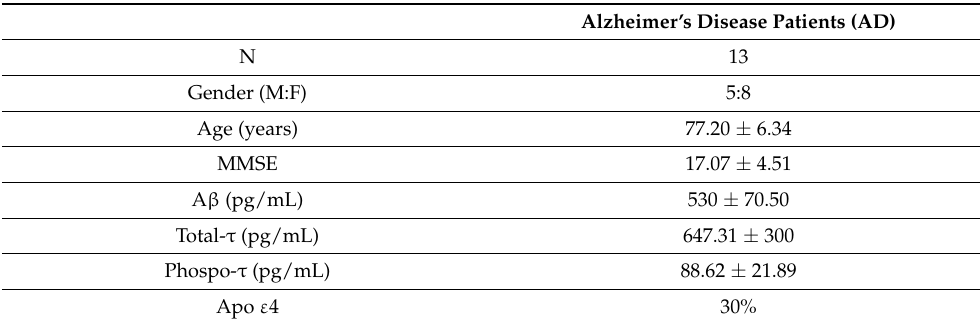
Table 1. Demographic, clinical, and genetic characteristics of the individuals enrolled in the study.